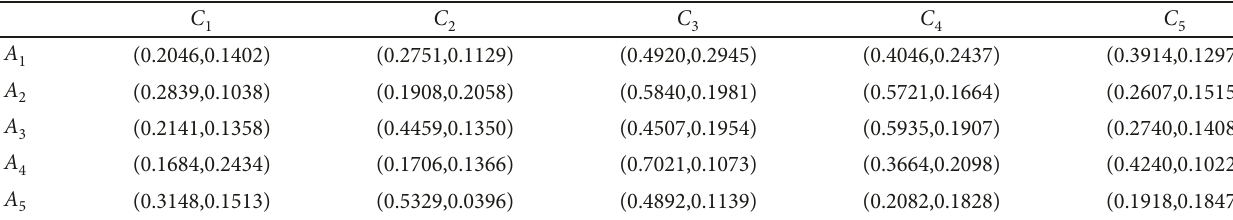
Table 7: Pythagorean fuzzy weighted decision matrix D ′ .